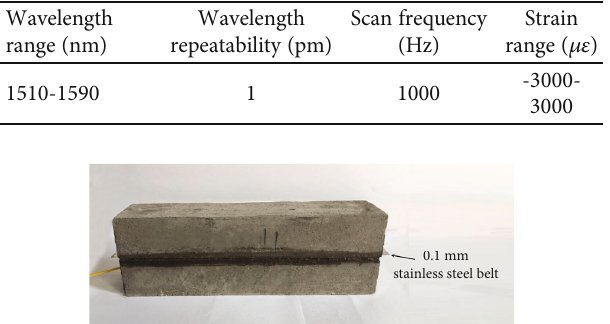
Figure 2: Details of the FBG sensors in the core specimen: (a) layout of the FBG strain sensing sensors and (b) installation of FBG sensors. Table 2: Typical parameters of the FBG technology.